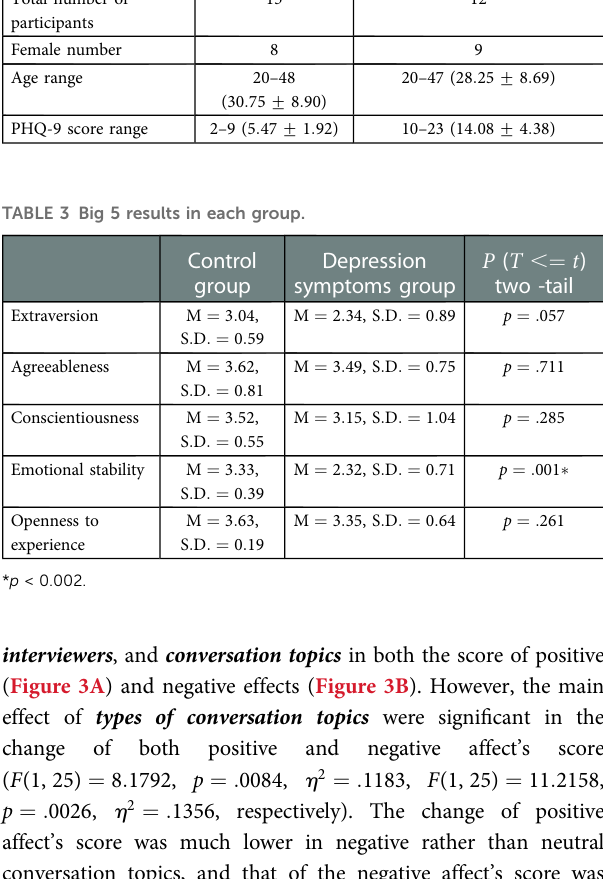
both the control and depression symptoms group.